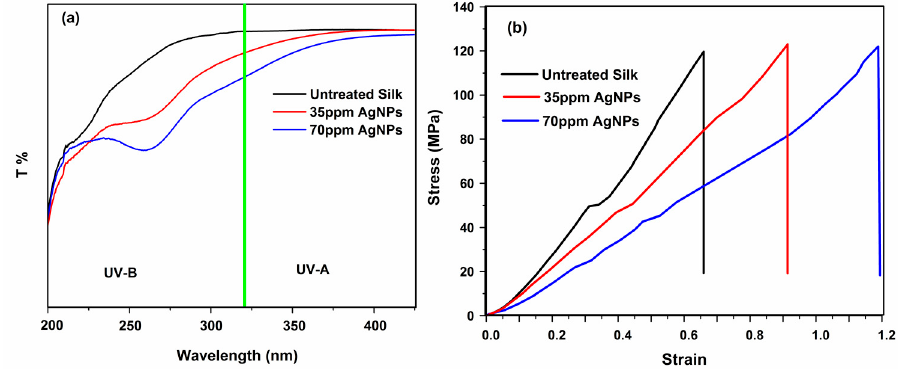
Figure 8. ( a ) UV transmission spectra and ( b ) stress–strain curve for the untreated and AgNPs-treated